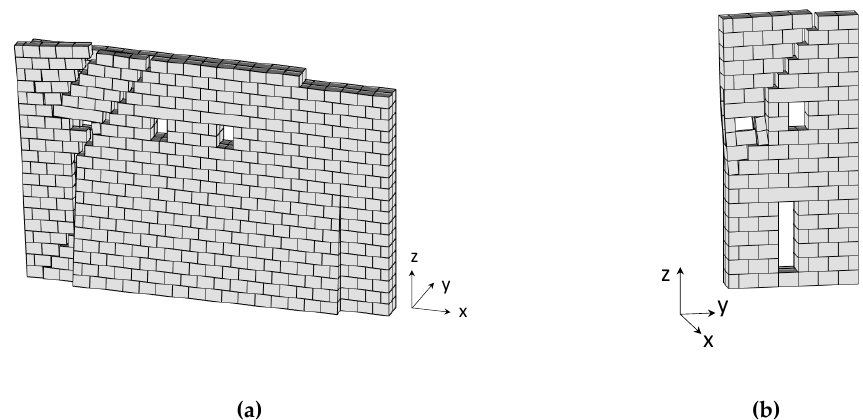
Figure 8. The in-pane collapse mechanism provided by LiABlock_3D: ( a ) the F1 for live loads along the negative x-axis; ( b ) the F4 façade for live loads along the negative y-axis.